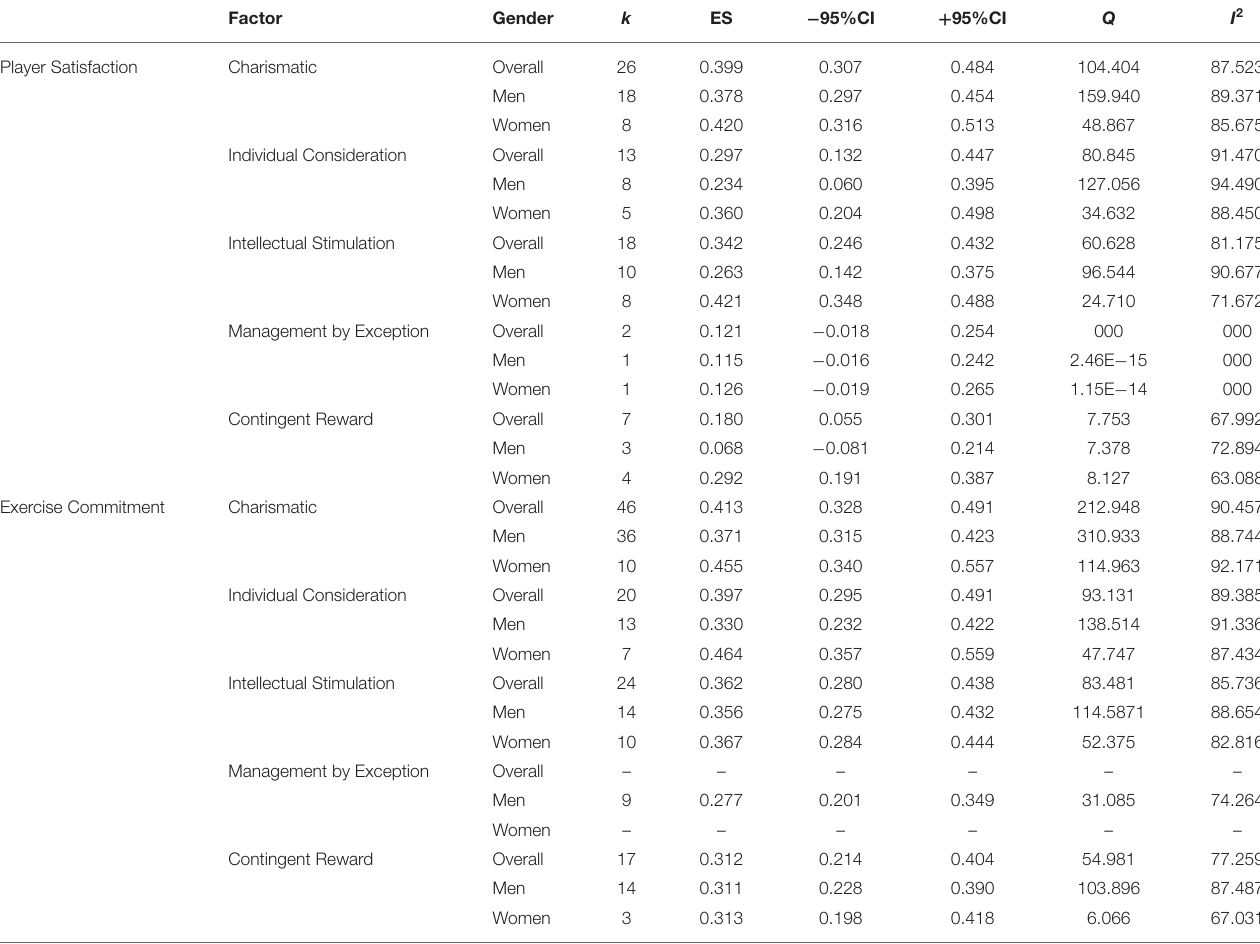
TABLE 2 | Results of meta-analysis of the relationships between subfactors of the MLQ and player satisfaction and exercise commitment by